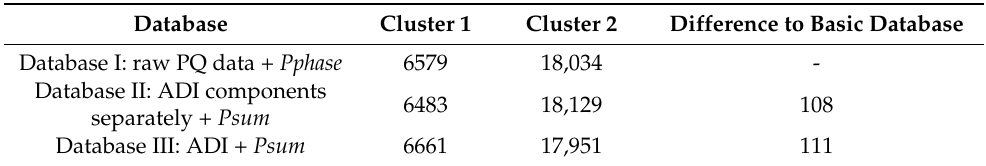
Table 2. The number of 10 min data points in each cluster for different input databases, and simplified comparison.